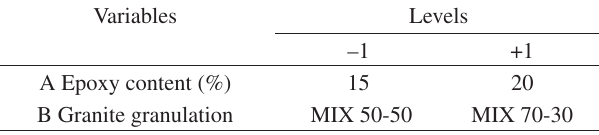
Table 2. Variables and levels adopted in Factorial design 2 2 .